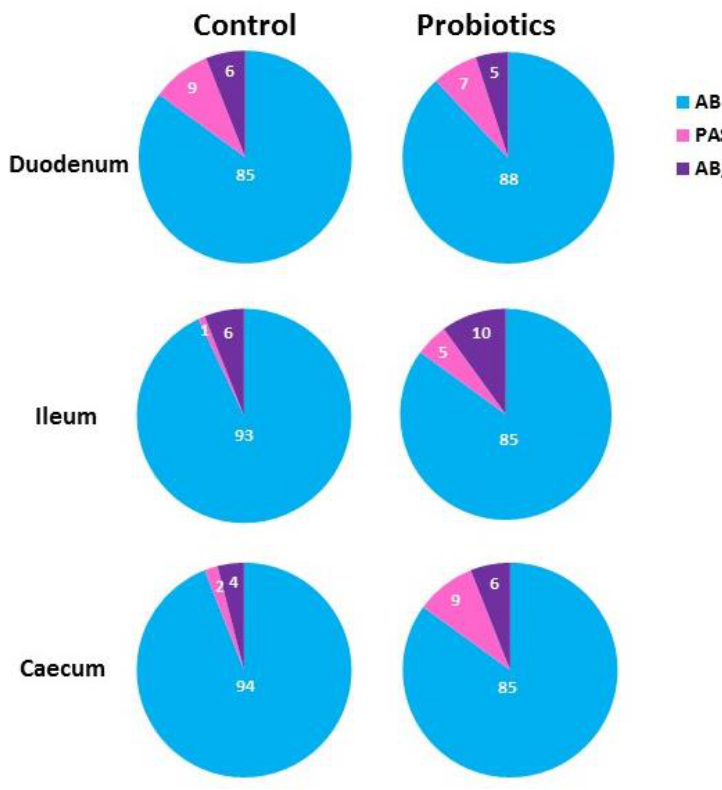
Figure 1. Percentage of the intestinal goblet cells of C and P guinea fowls stained with Alcian Blue pH2.5 (AB) (blue), PAS (magenta) and both AB2.5 and PAS staining (violet).